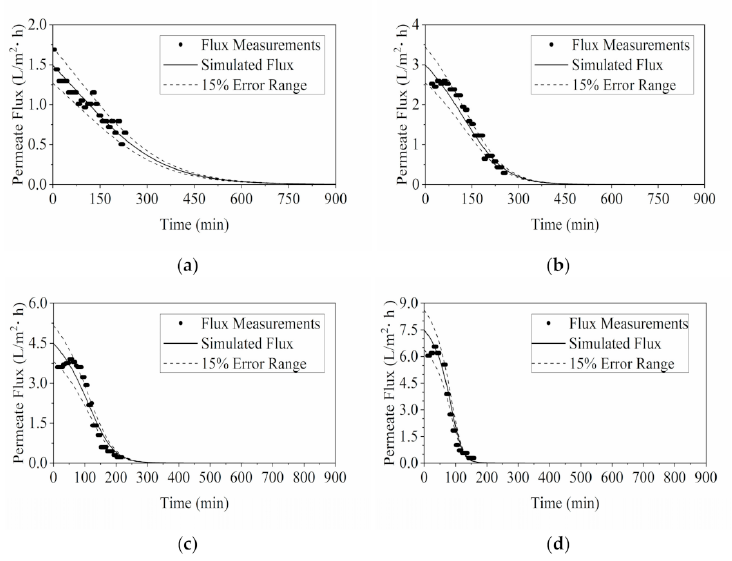
Figure 3. Validation of RO model via comparing the simulation results of permeate flux with the flux measurements taken during the experiments with different operating pressures: ( a ) 0.3 MPa; ( b ) 0.45 MPa; ( c ) 0.6 MPa; and ( d ) 0.9 MPa.